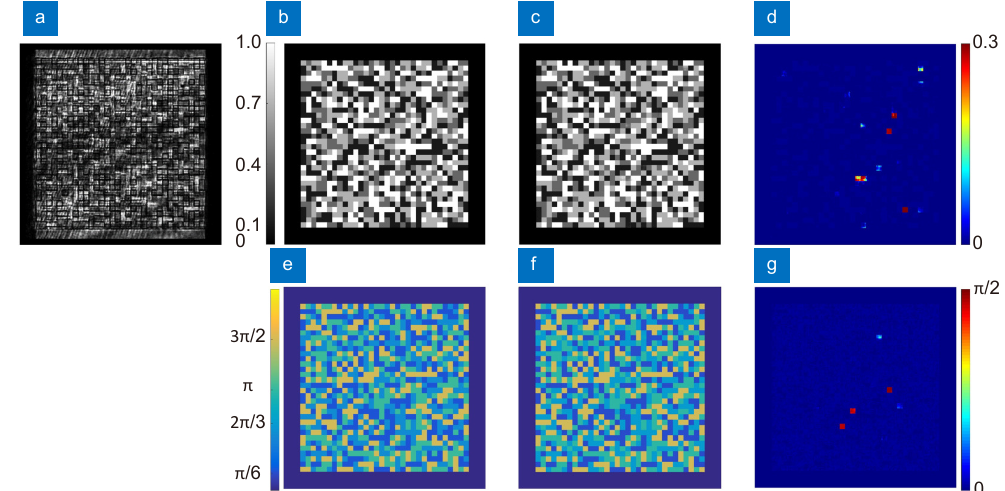
Fig. 11 | Experimental results. ( a ) Diffraction intensity image at z = 2 mm. ( b ) Ground truth of amplitude data page. ( c ) Amplitude predicted by CNN1. ( d ) Difference between retrieved amplitude (c) and amplitude ground truth (b). ( e ) Ground truth of the phase data page. ( f ) Phase data page predicted by CNN2. ( g ) Difference between the retrieved phase data page (f) and the phase ground truth (e).